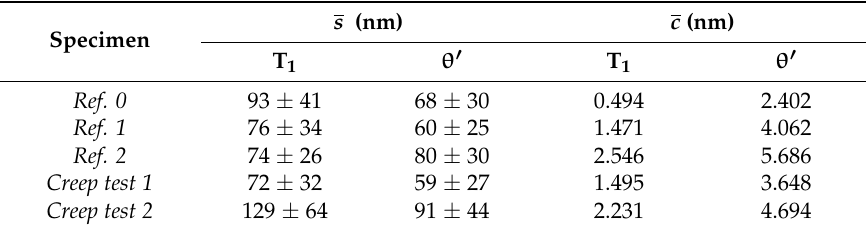
Table 4. Mean line length, s , with standard deviation and mean thickness, c , of T 1 and θ (cid:48) precipitates depending on the aging